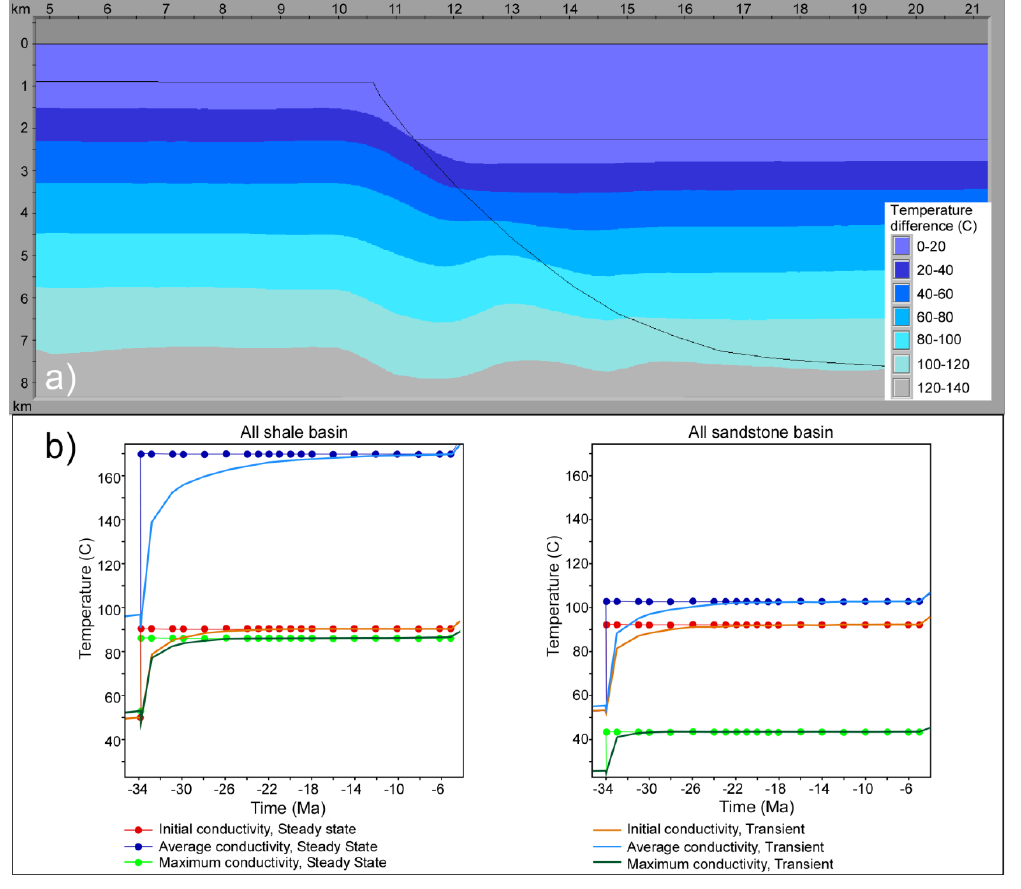
Figure 10. (a ) Thermal difference between transient temperatures of basin (10 kyr after fault slip) modeled with average conductivity to basin modeled with default conductivity. ( b ) Point plot results from location of point given in Figure 8b, showing the steady state and transient temperatures for the three tested conductivities for shale and sandstone. Conductivity values given in Table 2.